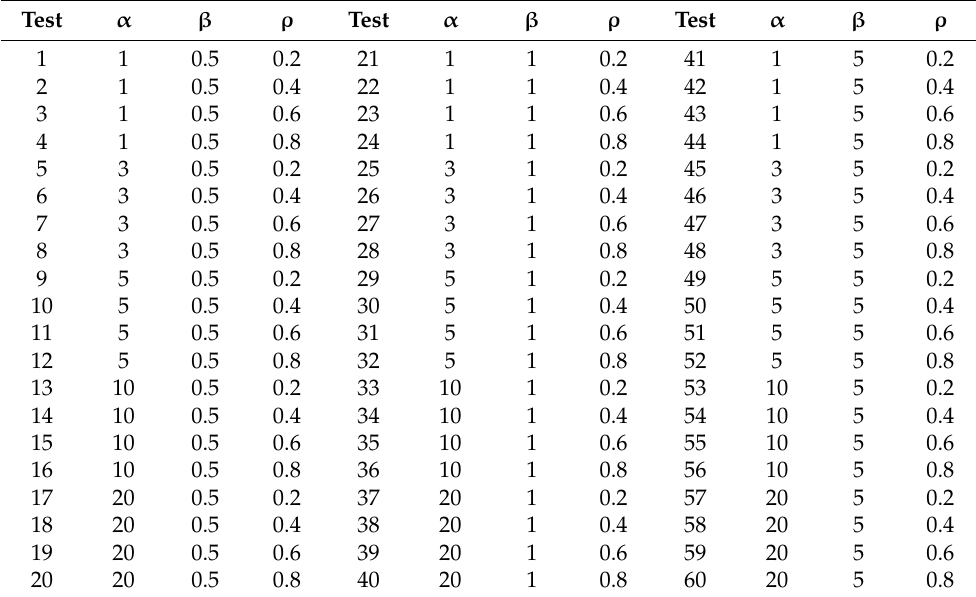
Table 8. Test settings of ant colony algorithm parameters.